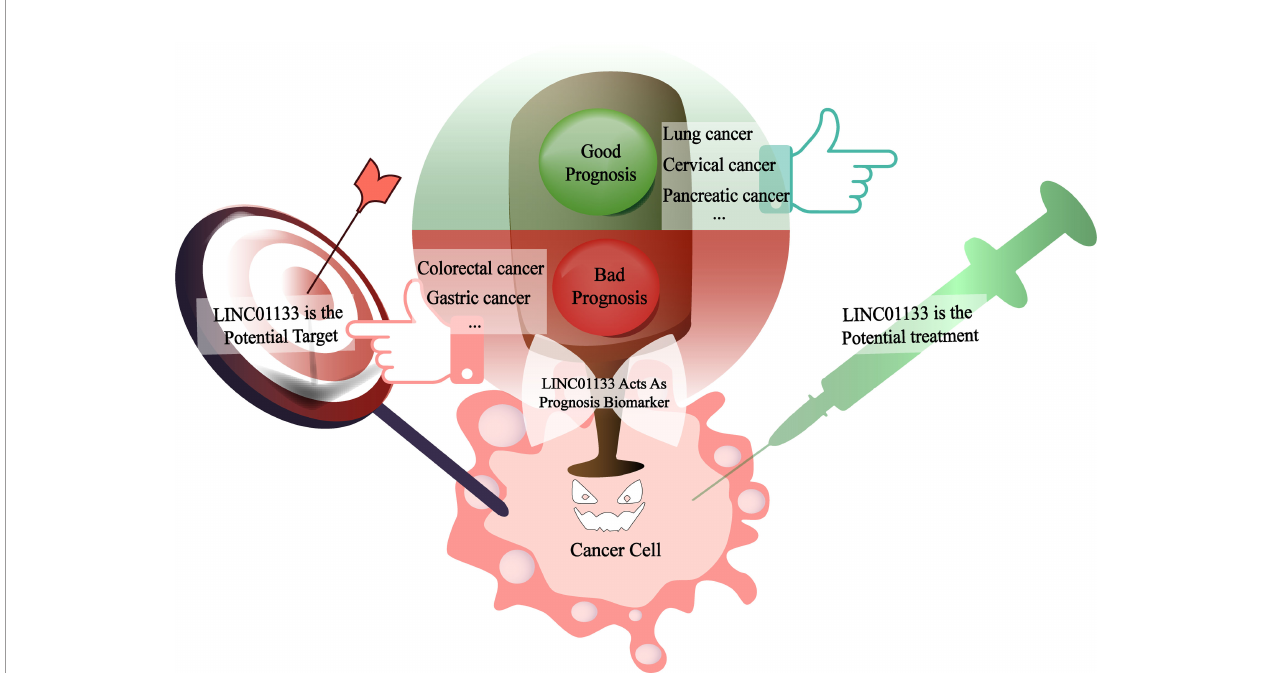
FIGURE 5 | LINC01133 is the biomarker of cancer prognosis as well as the potential therapeutic target or treatment reagent in the future. When LINC01133 acts as an oncogene, its high expression suggests a bad prognosis of patients as shown in the red section and might be a potential therapeutic target molecular for the clinical treatment. In the contrary, when LINC01133 acts as a cancer suppressor, its high expression indicates a good prognosis of patients as shown in the green section and might be a potential treatment reagent in the